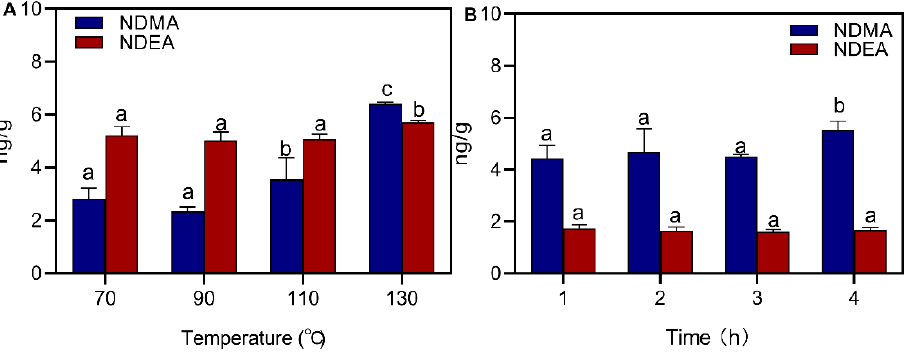
Figure 3. Effect of processing temperature and time on NDMA and NDEA. ( A ) temperature; ( B ) time. Different letters above the bars indicate significant differences (n = 3, p < 0.05). N- nitrosodimethylamine (NDMA) and N-nitrosodiethylamine (NDEA).